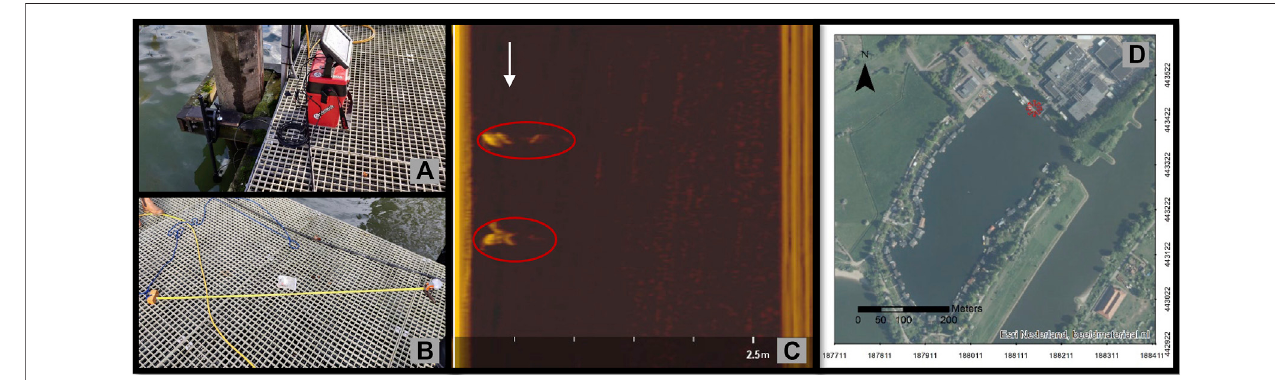
FIGURE2|(A) Theset-upoftheSSSinthedockoftheRosandepolderRWSfacilityforthesemi-controlledexperimentinstandingwater, (B) aplasticobject(lunch meat packet) and the wood fl oat and towing rope, (C) a view of the plastic bottle as it appeared twice in the sonar image when moved on the starboard side of the transducer (white arrow indicates the direction of towing), and (D) map of the Rosandepolder RWS facility used for the SSS standing water test. The exact location is denoted by the red asterisk. Photos by N.Y. Flores. Aerial images source: Environmental Systems Research Institute (ESRI) Nederland, beeldmateriaal.nl.